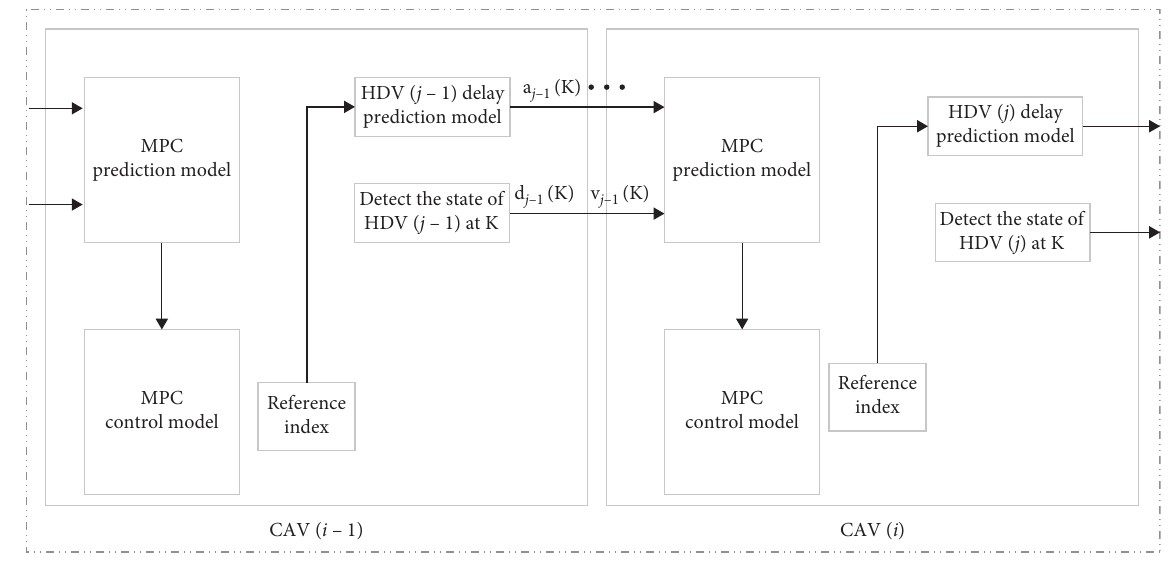
Figure 2: CAVs information interaction and DMPC control in the fleet.